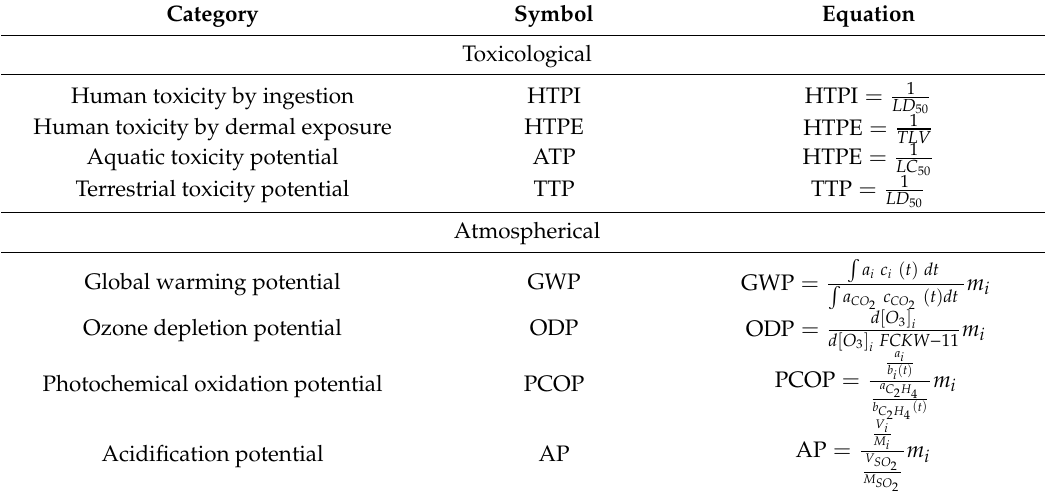
Table 8. Description of the impact categories in waste reduction algorithm